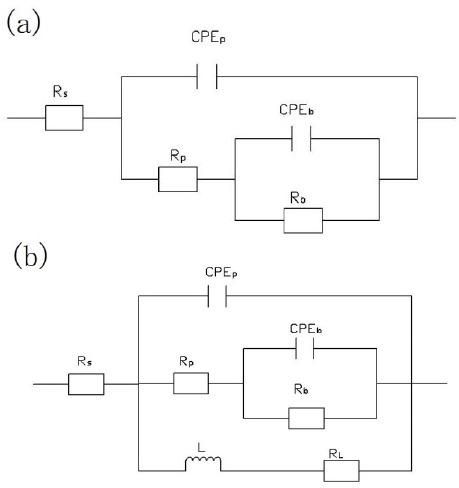
Figure 11. Equivalent circuits of the EIS plots at different immersion times: ( a ) 24 h, 48 h, 96 h; ( b ) 192 h, 384 h, 768 h.